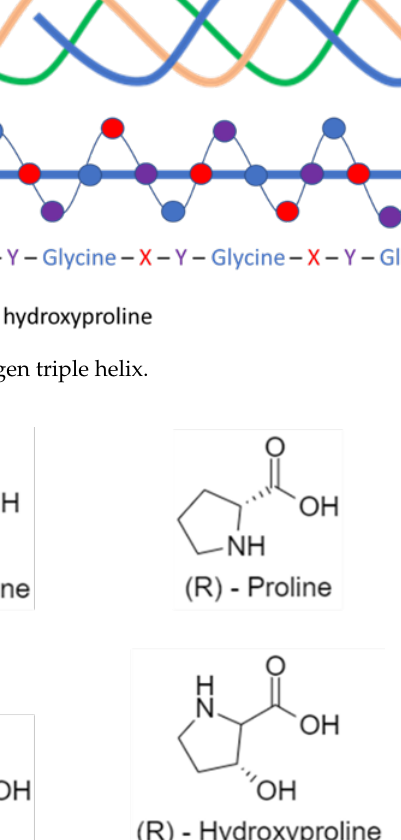
Figure 2. Main amino acids present in leather.